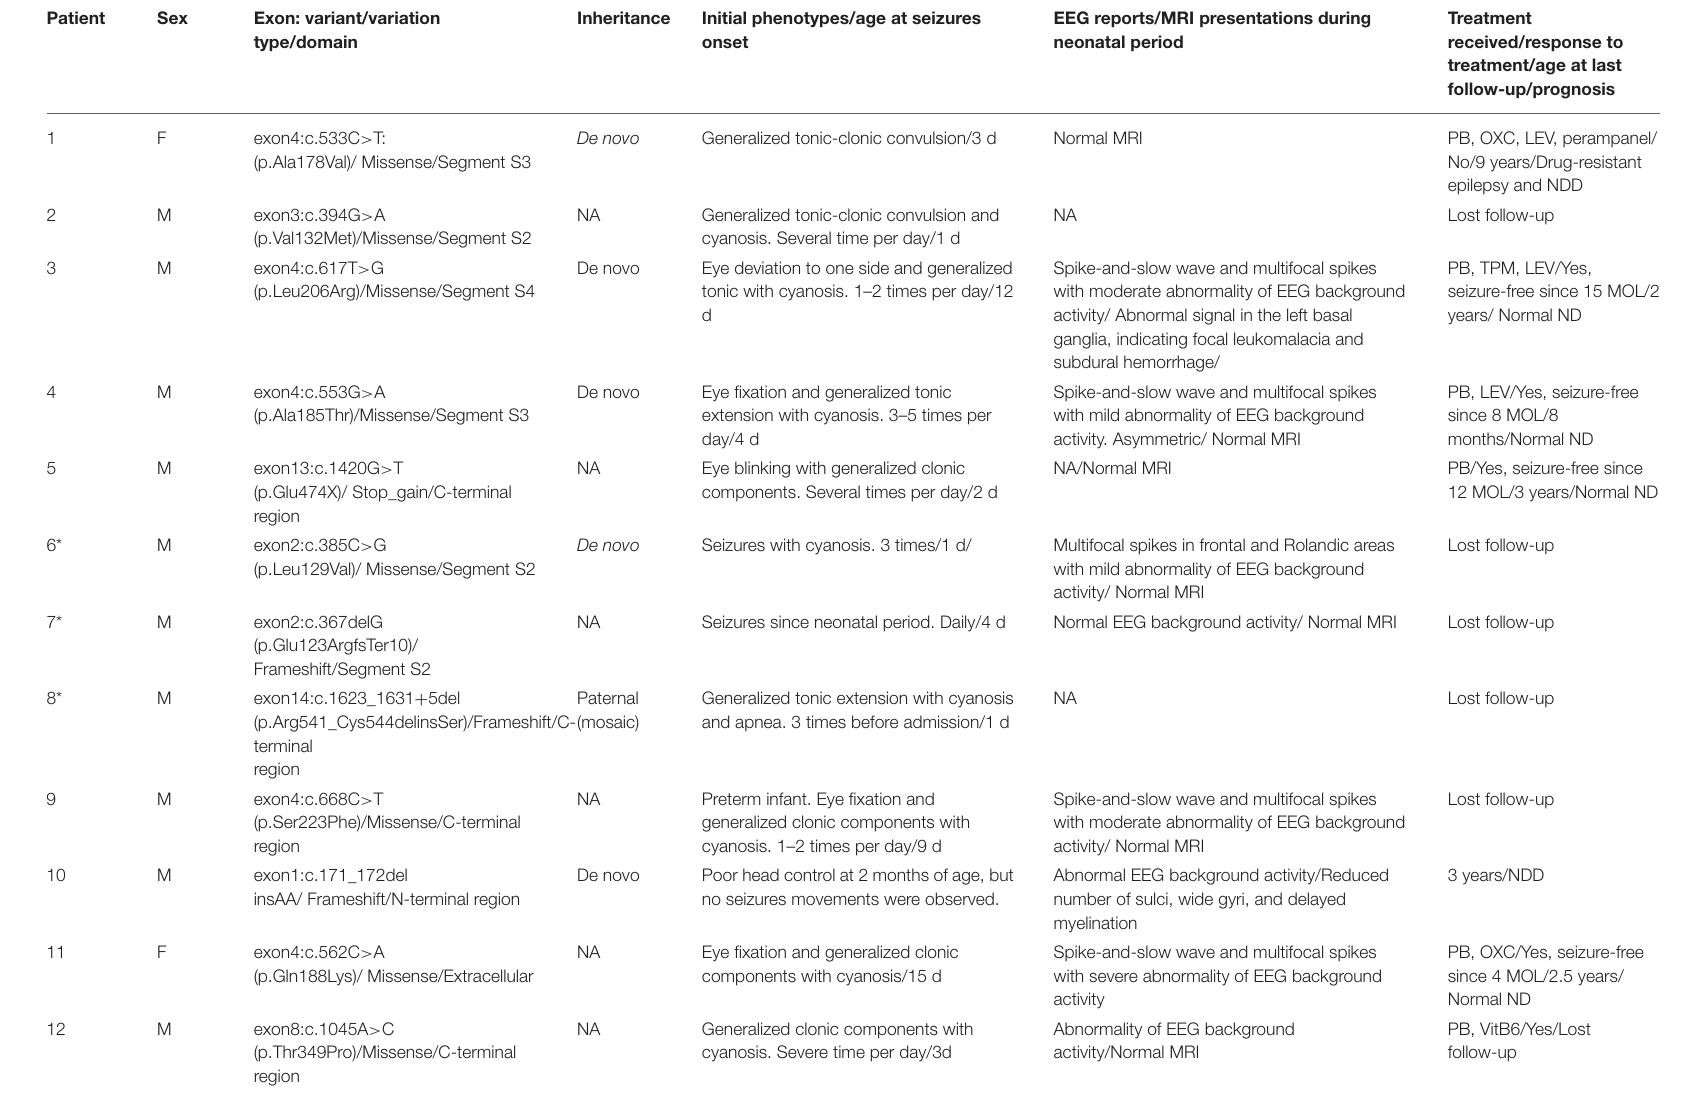
TABLE 1 | Novel variants in KCNQ2 gene identified in 19 neonates with KCNQ2 -related disorders.